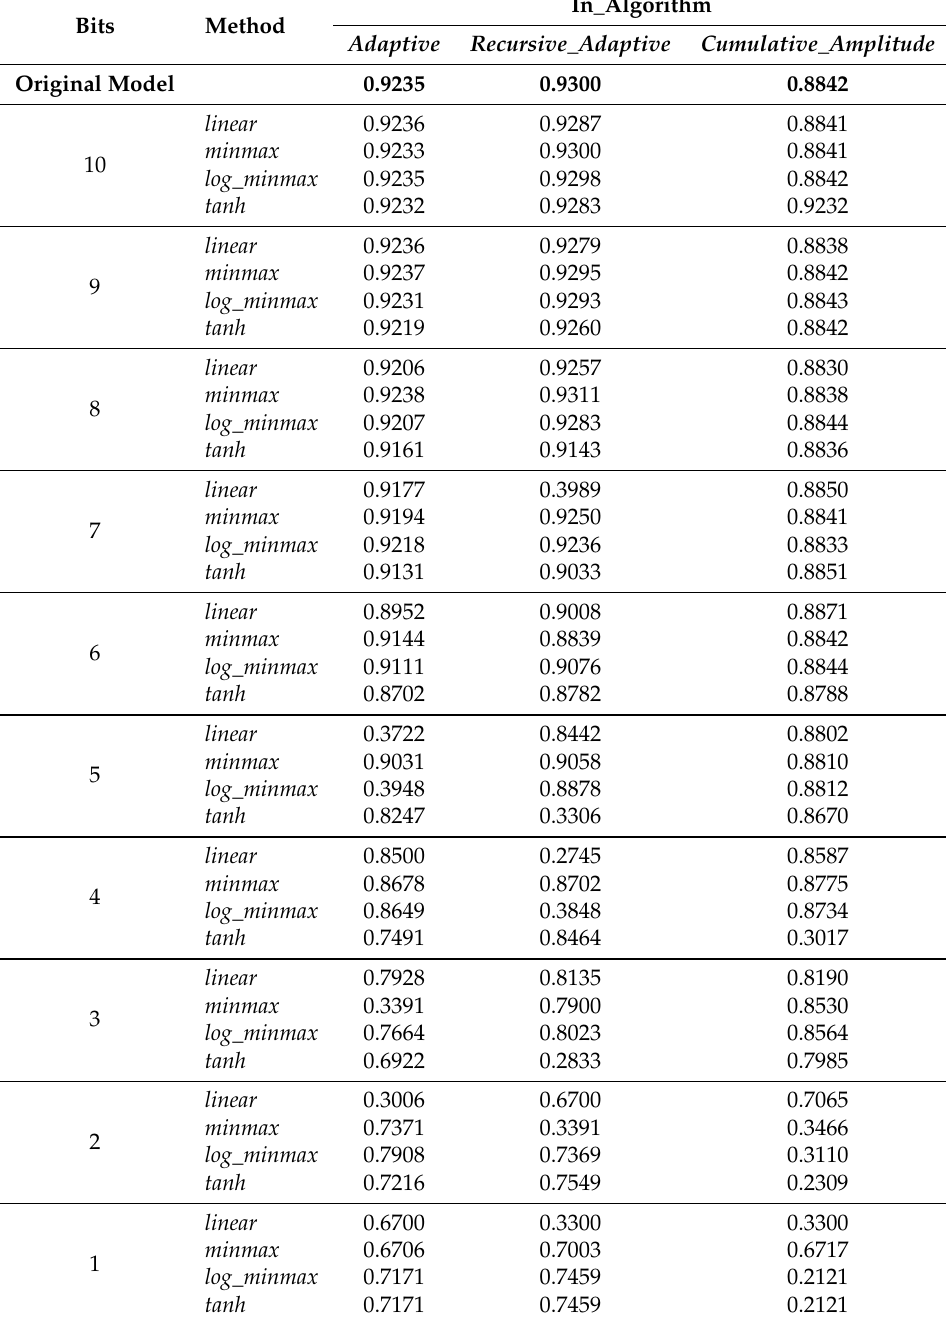
Table 4. Coefficients Quantization Results for GRU (two layers, 64 and 32 cells) + Dense, trained on four input channels. Accuracy as a function of